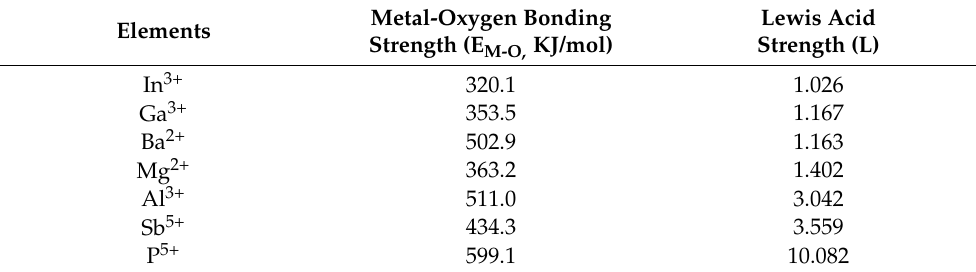
Table 1. Metal-oxygen bonding strength (E M-O ) and Lewis acid strength (L) of elements. Metal-Oxygen Bonding Elements Strength (E M-O, KJ/mol)